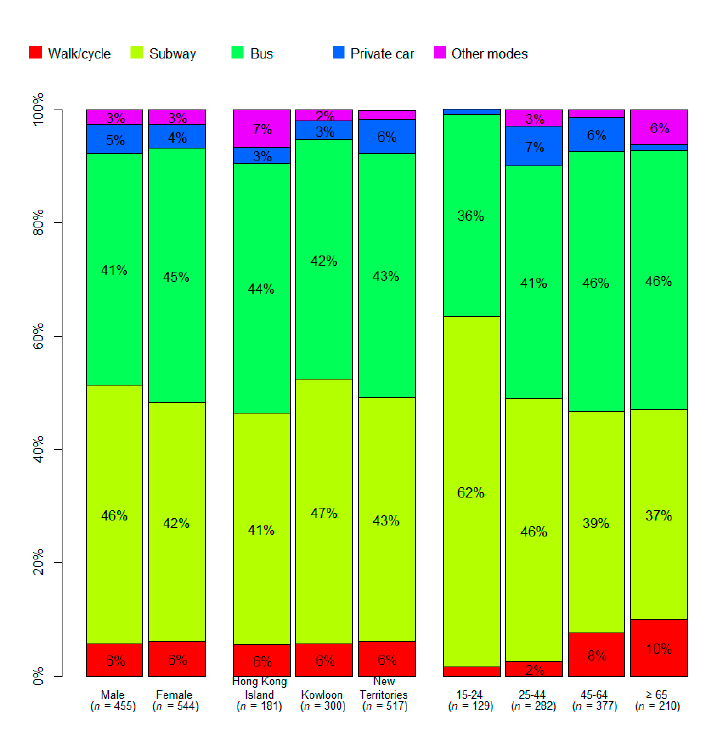
Table 2. Pattern of daily transport and level of perceived safety.